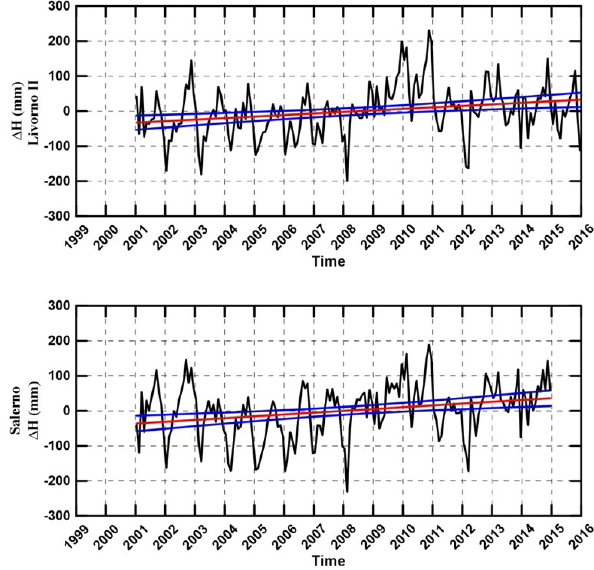
Figure 11. Black line indicates the monthly water level oscillations recorded at ISPRA tide gauges set in Livorno and Salerno. Red line indicates the linear fit curve of the sea level and blues lines the two 95% confidence